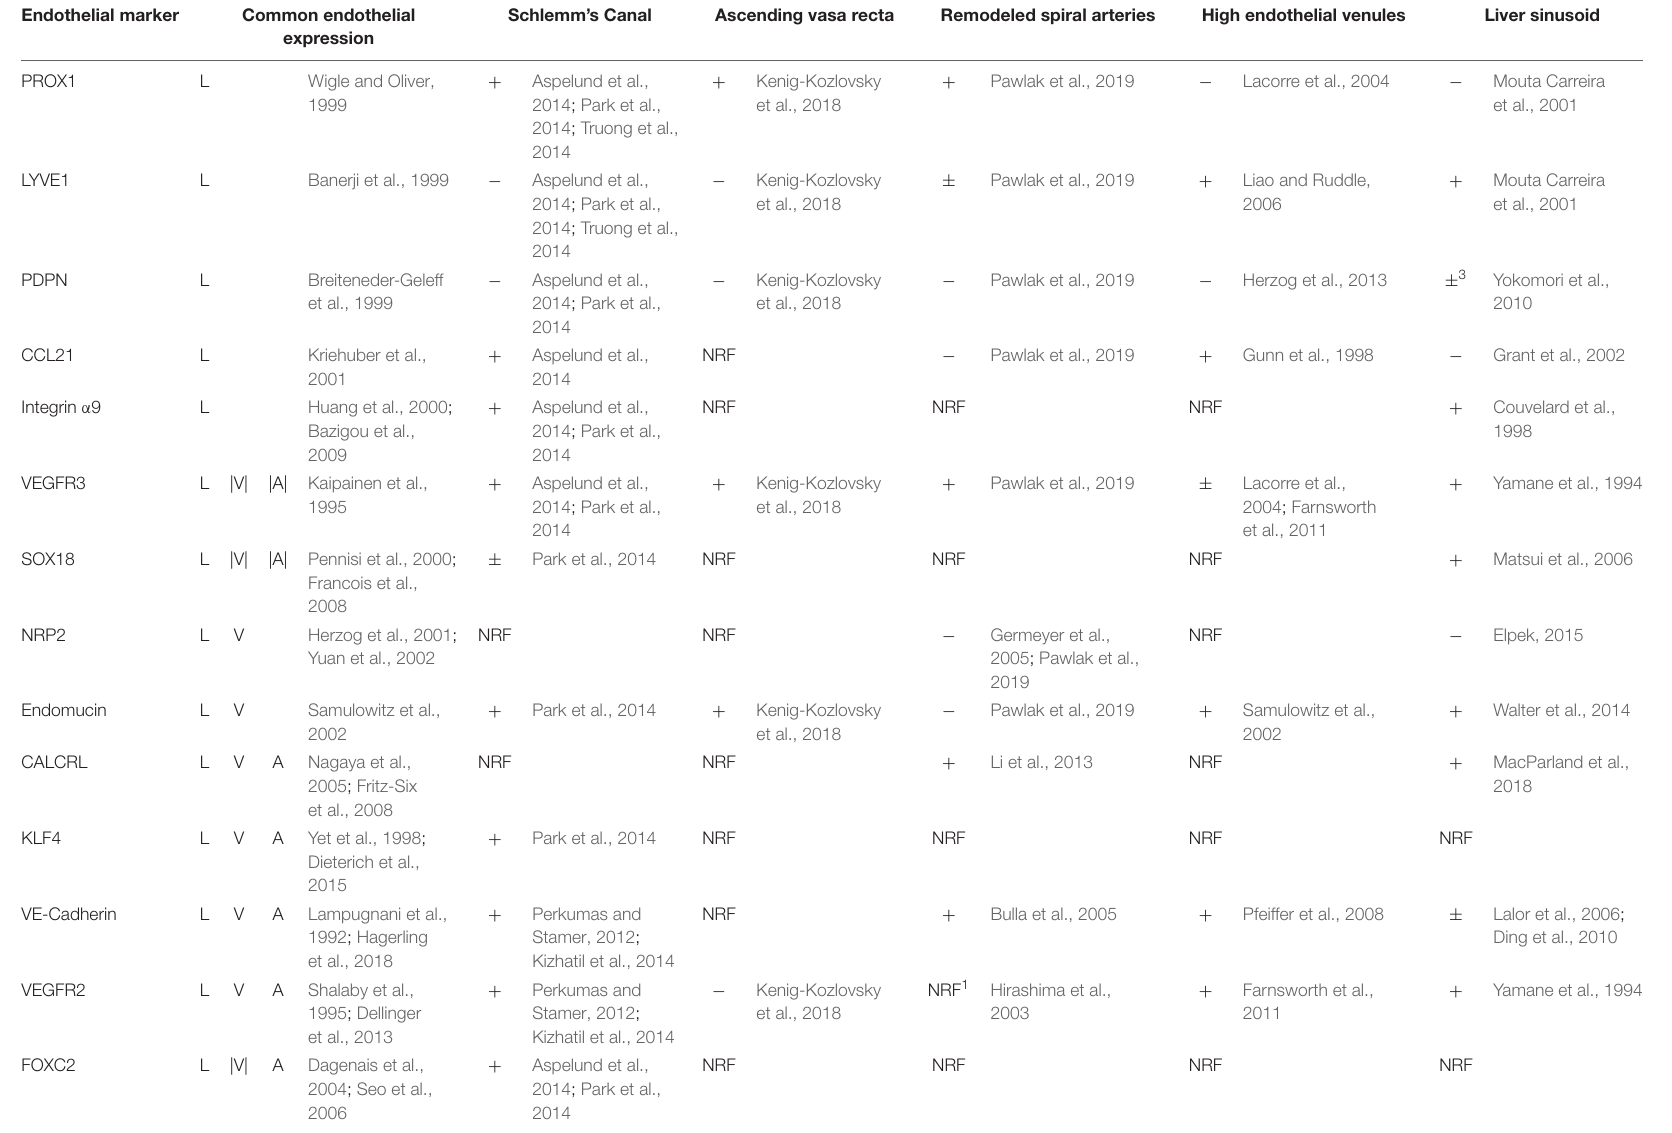
TABLE 1 | Expression pattern of hybrid